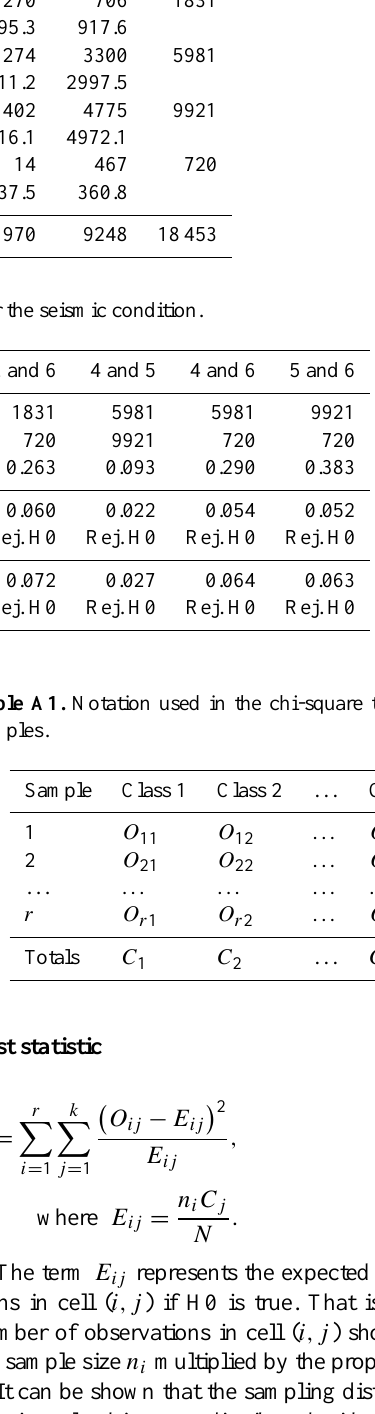
Table 13. Summary of results applying the chi-square test for the seismic condition. Zone cd 1